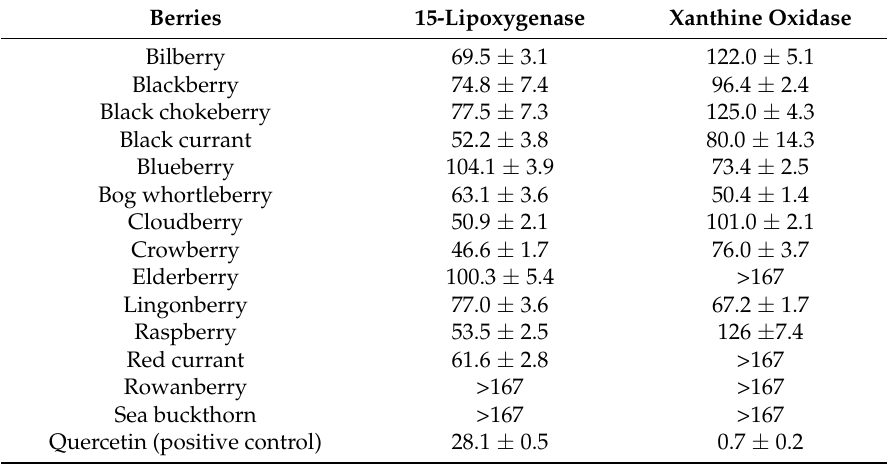
Table 4. 15-Lipoxygenase (15-LO) and xanthine oxidase (XO) inhibition of methanol SPE extracts with IC 50 values ± SD (in µ